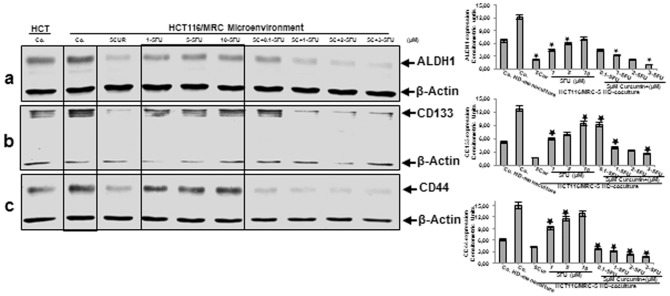
Curcumin sensitizes colon cancer stem cells to 5-FU in the high density tumor microenvironment co-culture.HCT116 high density mono-cultures were either left untreated (HCT, Co.) or were co-cultured with MRC-5 in tumor microenvironment. Tumor microenvironment co-cultures were either left untreated (Co.), treated with curcumin alone (5µM), 5-FU alone (1, 5, and 10µM) or were pretreated for 4 h with curcumin (5µM) followed by treatment with 5-FU (0.1, 1, 2, 3µM). After 10 days of culture, total cell lysates of HCT116 high density cultures were prepared and analyzed by western blotting and quantitative densitometry for CSC marker ALDH1 (a), CD133 (b) and CD44 (c). Densitometric evaluation of protein expression as revealed by western blot analysis was performed in triplicate. Housekeeping protein β-actin served as a loading control in all experiments. Values were compared to the control and statistically significant values with p<0.05. Significant values are marked with (*).